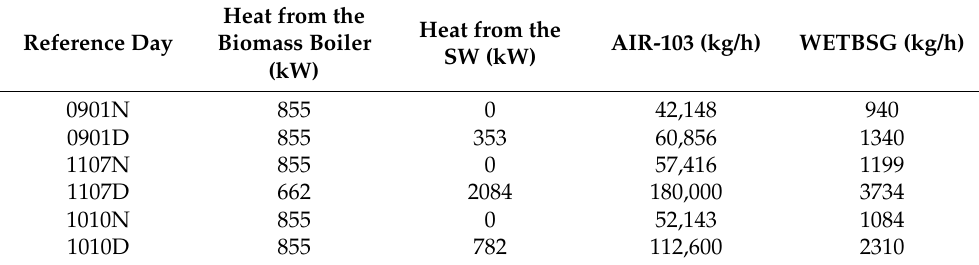
Table 6. Effect of weather fluctuations on the drying